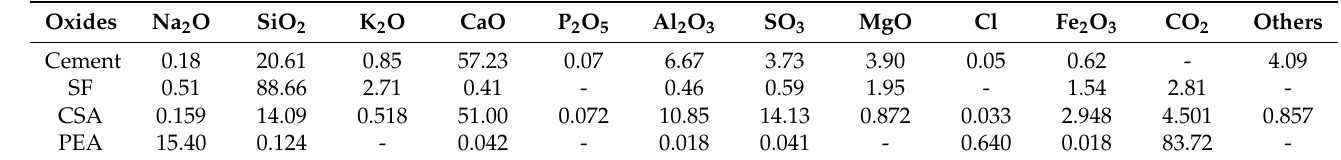
Table 1. Chemical compositions of the cementitious materials and admixtures/%.